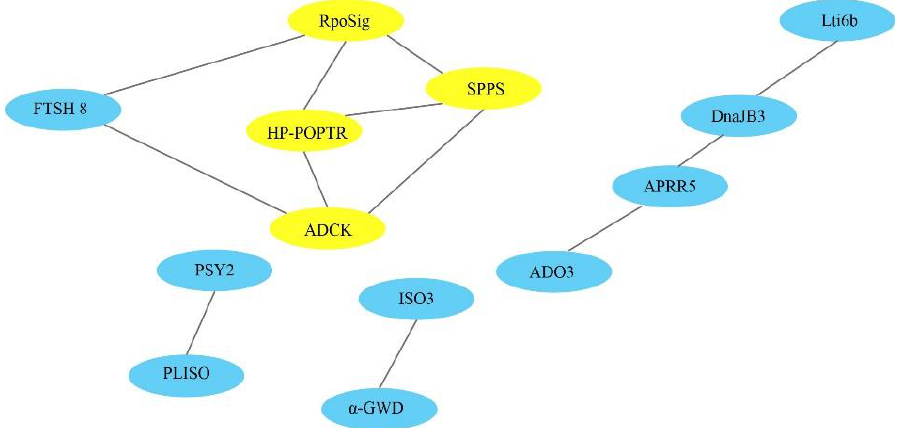
Figure 3. Interaction networks of upregulated DEGs in the drought-tolerant species CDR-1. Yellow ellipses show that genes interacted with at least three other genes. Blue ellipses show that genes interacted with fewer than three other genes. RpoSig, RNA polymerase sigma factor (AT5G24120.1); SPPS, solanesyl-diphosphate synthase (AT1G17050); HP-POPTR, hypothetical protein POPTR_0019s08420g (AT3G56290.1-P); ADCK, aarF domain-containing protein kinase (AT3G24190.1); FTSH 8, ATP-dependent zinc metalloprotease FTSH 8 (AT1G06430.1); Lti6b, PM-YC3.6-Lti6b (AT3G05890.1); DnaJB3, DnaJ homolog subfamily B member 3 (AT1G56300.1); APRR5, two-component response regulator-like APRR5 (AT5G24470.1); ADO3, adagio protein 3 (AT1G68050.1); PSY2, phytoene syn- thase 2, chloroplastic-like (AT5G17230.3); PLISO, prolycopene isomerase, chloroplastic (AT1G57770.1); ISO3, isoamylase 3, chloroplastic (AT4G09020.1); α -GWD, alpha-glucan water dikinase, chloroplastic